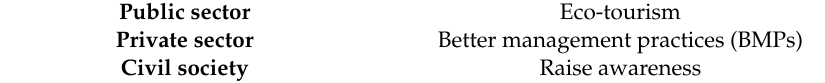
Figure 1. The perceived problems of the 50 participants and their responses. Table 1. The perceived problems (ranking).